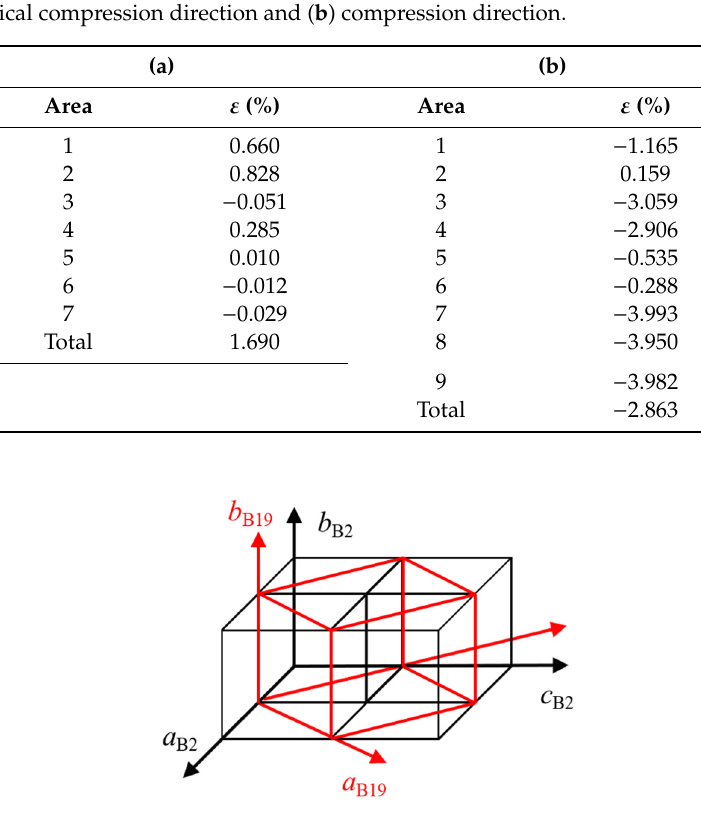
Figure 6. Lattice correspondence between B2 parent phase and B19 martensite phase.